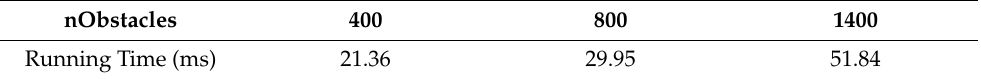
Table 5. Performance measure for real time; state of curved road, k 1 = 0.5, k 2 = 0.3, and length 100